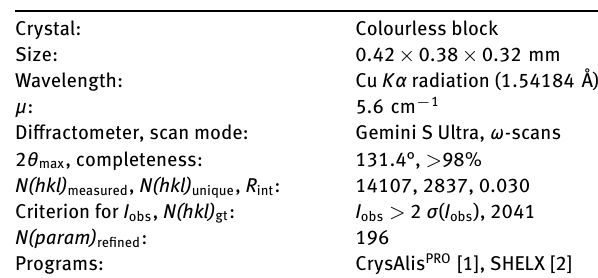
Table 1: Data collection and handling.